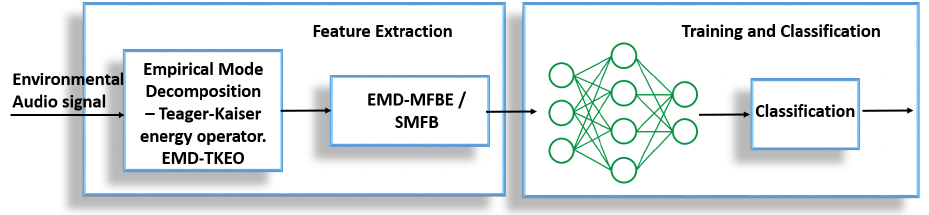
Figure 1. Block diagram of proposed system—feature extraction using EMD-TKEO method and classification using neural